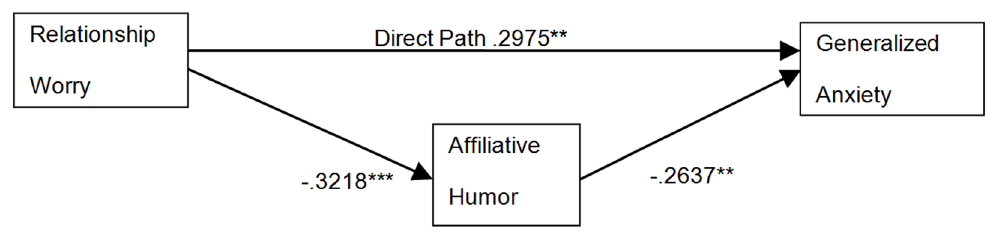
Figure 2. Affiliative Humor as a significant mediator between Relationship Worry and Anxiety. ** p < .025. *** p <